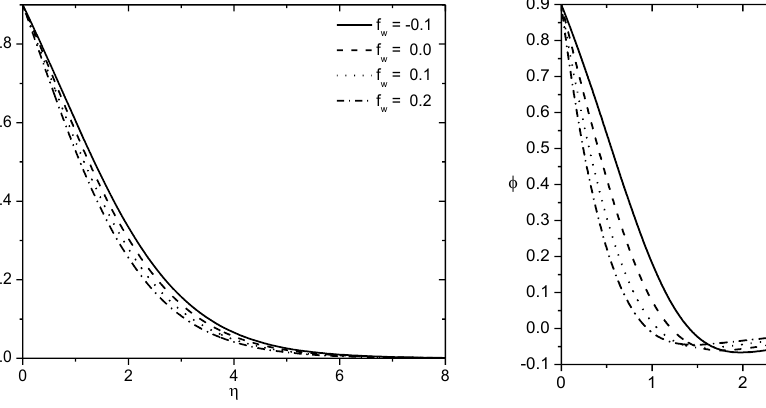
Figure 5. Effet of f w on the Temperature Figure 6. Effet of f w on the Solid volume fraction